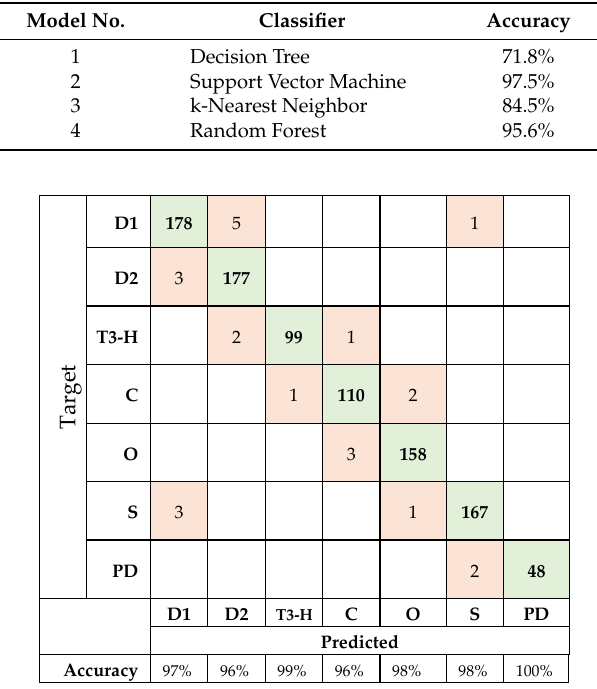
Figure 3. Confusion matrix of 961 data of SVM-based DPM. Table 9. 10 Samples of SVM-based DPM prediction.